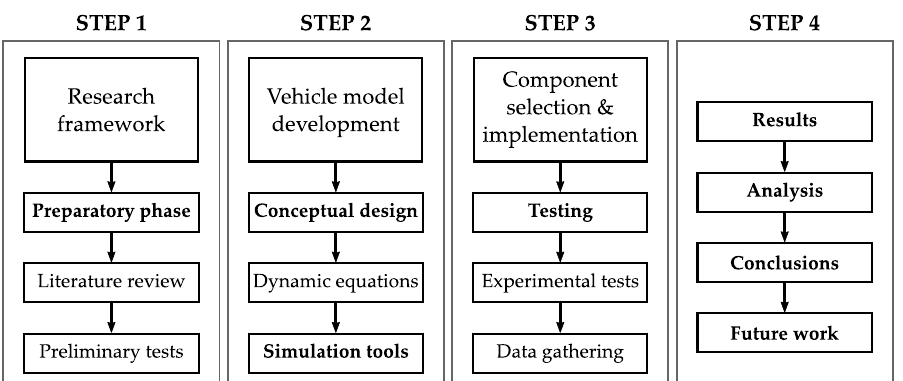
Figure 1. Optimization methodology of the final